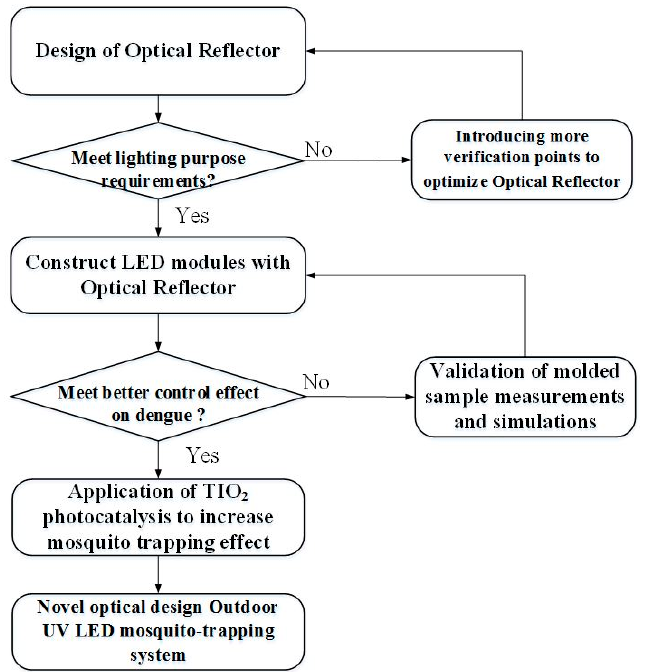
Figure 4. Workflow of optical-reflector design .